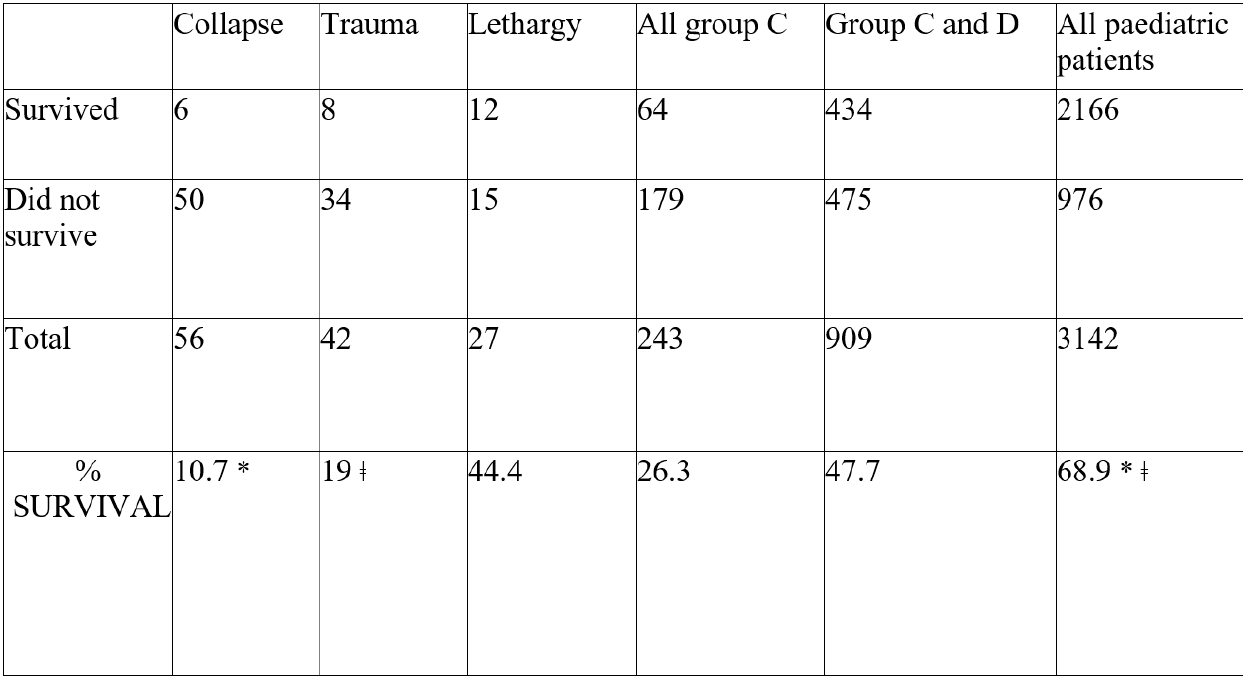
Table 4: Outcome recorded for the three most common presentations for the feline patients < 3months old who attended the clinic and followed veterinary advice. Categories indicated by matching symbols ( * ǂ § ʃ ¢) indicate pairs where survival was significantly